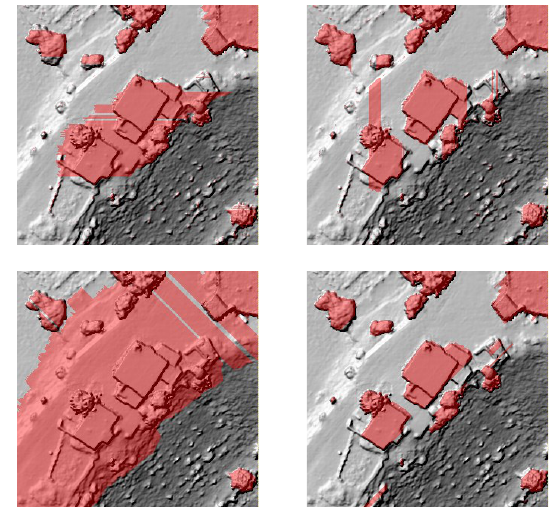
Figure 5. A visualization of the four masks representing four directions. Clockwise starting from top left: E-W, N-S, NE-SW and NW-SE.